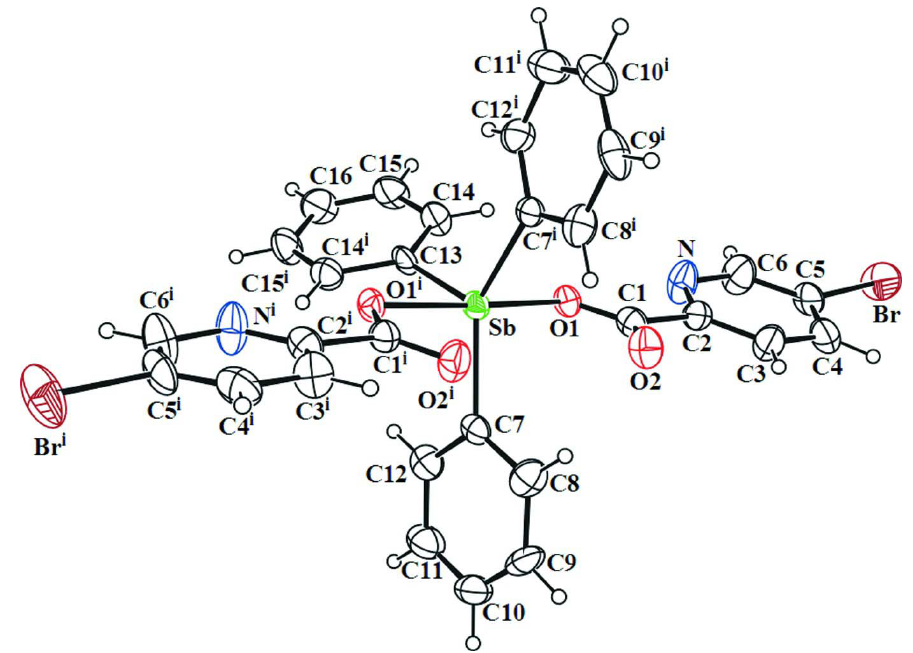
Figure 1 The molecular structure of the title compound, showing displacement ellipsoids drawn at the 30% probability level. [Symmetry code: (i) -x+1, -y+1,